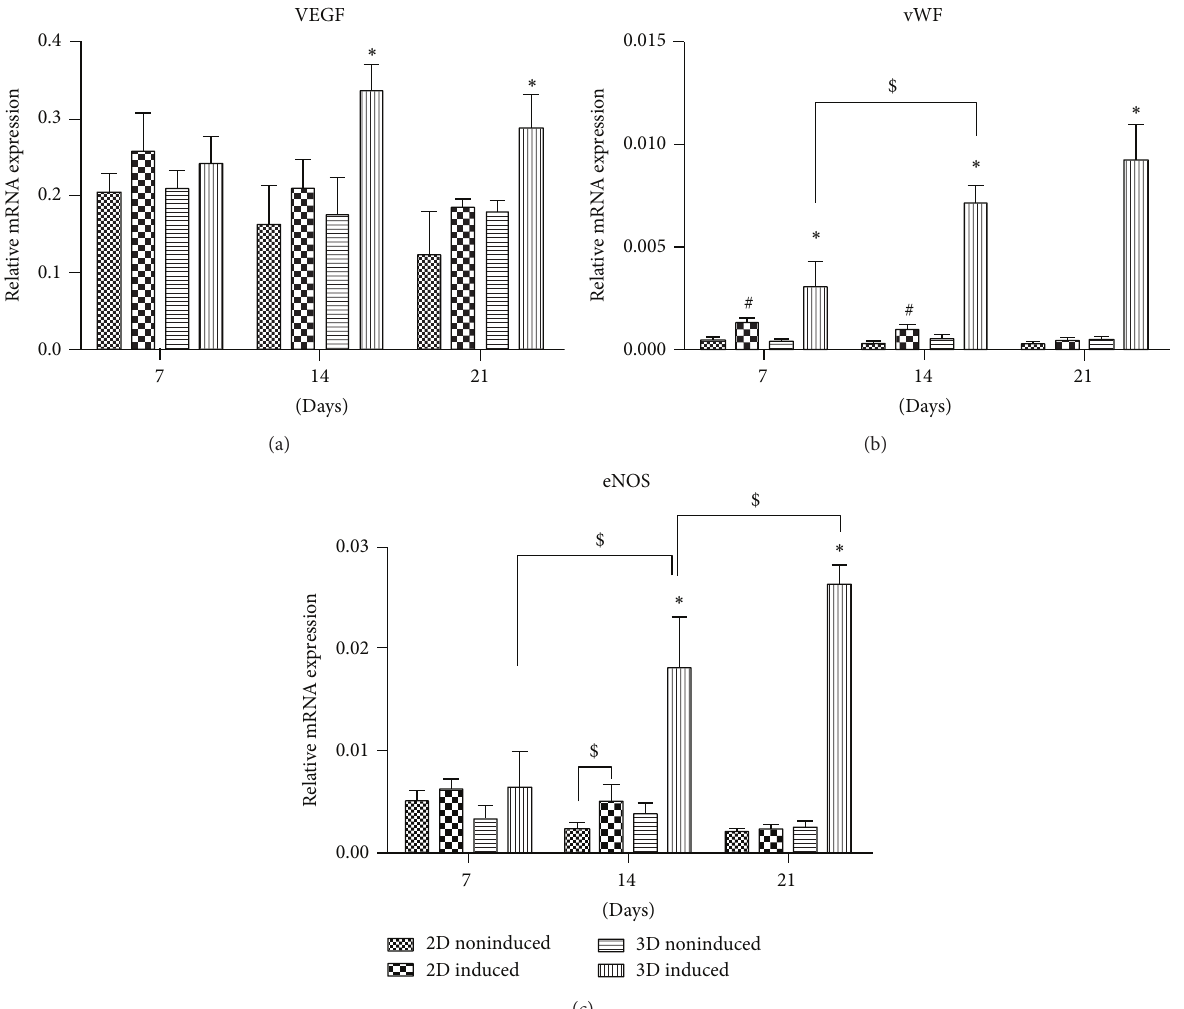
Figure 5: mRNA expression of endothelial related genes. Gene expression of VEGF, vWF, and eNOS in the 3D induced, 3D noninduced, 2D induced, and 2D noninduced hADSCs at 7, 14, and 21 days in vitro. ∗, # 𝑃 < 0.05 means being statistically different from the other 3 groups at the same time point. $ 𝑃 < 0.05 means being statistically different from each